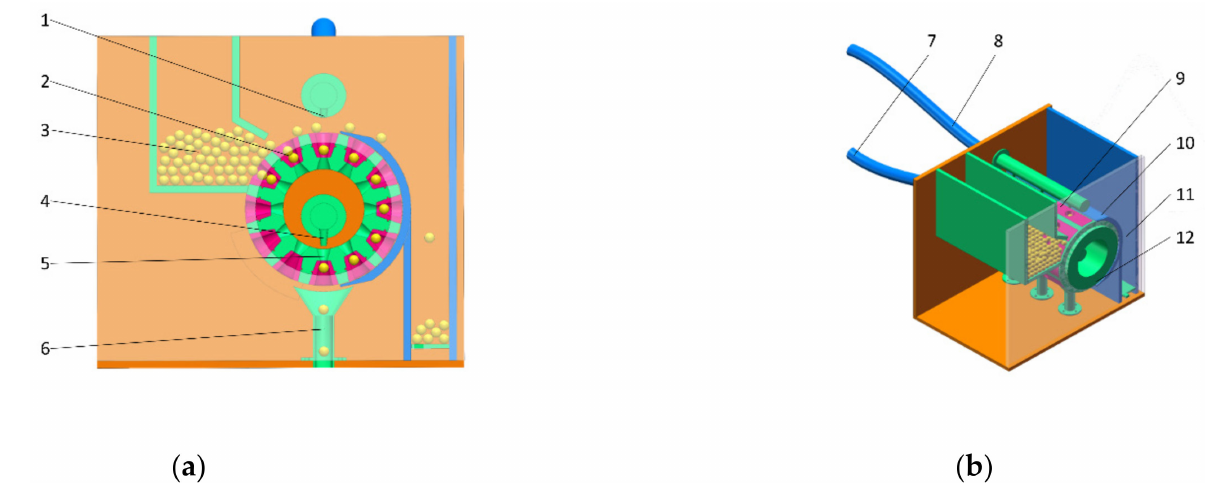
Figure 1. Sketch map of the general mechanical pneumatic combined seed metering device. ( a ) Front view; ( b ) Axonometric view. 1. Seed cleaning nozzle; 2. Seed filling hole; 3. Seed filling box; 4. Seed unloading nozzle; 5. Unloading seed pore; 6. Seed cup; 7. Seed unloading duct; 8. Seed cleaning duct; 9. Seed strips; 10. Protective seed plate; 11. Seed collection box; 12. Feeding